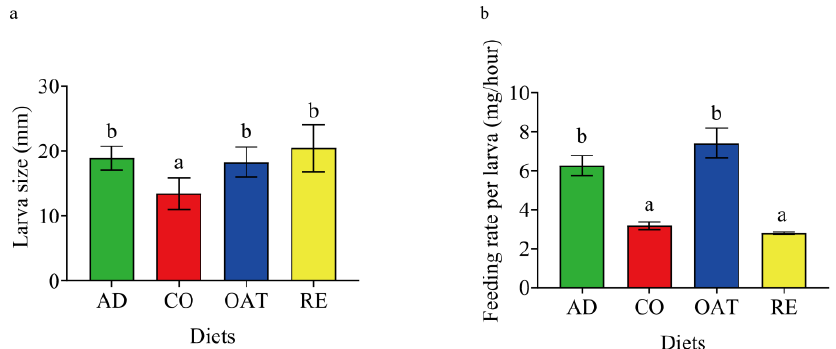
Figure 1. Effect of diet regimes on the performance of C. suppressalis larvae. ( a ) Larval size on each diet. ( b ) Feeding rate of larvae on each diet. AD: artificial diet, CO: corn diet, RE: rice diet, OAT: water oat diet, LAAD: larvae fed on an artificial diet, LACO: larvae fed on a corn diet, LARE: larvae fed on a rice diet, and LAOAT: larvae fed on a water oat diet. Different letters indicate significant differences across the treatments, p < 0.05.